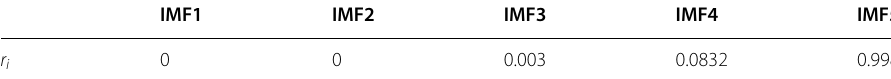
Table 4 Similarity between ideal signal and IMF components